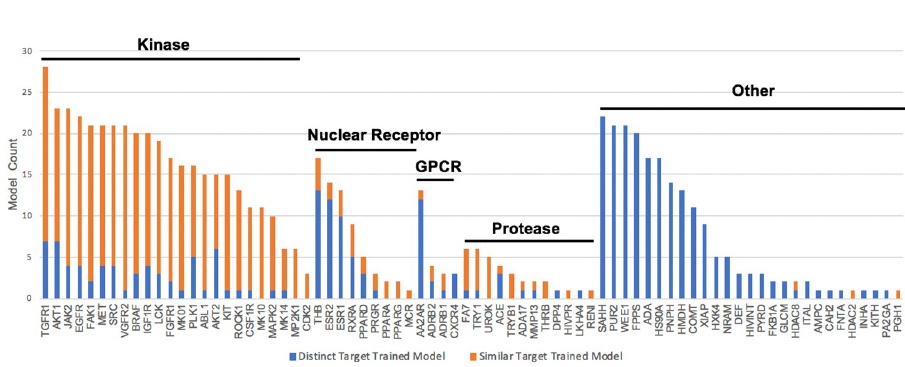
Fig 10. Total number of inter-target models that achieved AUC > 0.9 for each target in DUD-E. Targets are partitioned into subsets based on biological families. Targets from a different subset (or non-isoform targets in the "other" subset) are labelled “distinct targets” (blue). Targets in the same subset (except the “other” subset, unless an isoform exists) are labelled “similar targets” (orange). Targets that do not have inter-target high AUC ( > 0.9) are not shown.